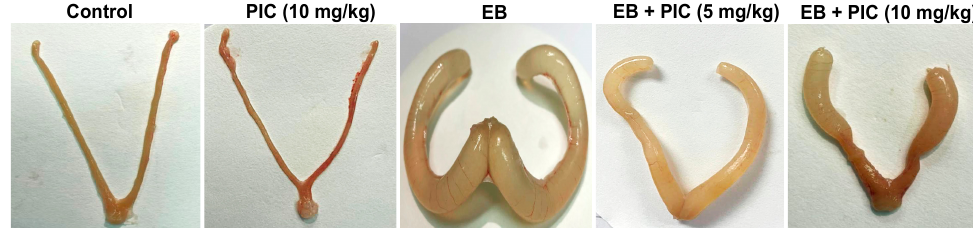
Figure 1. Effect of piceatannol SNEDDS on uterine morphology in rats treated with estradiol benzoate. Gross images of rat uteri collected after four weeks of treatment with estradiol benzoate (0.6 mg/kg) in the absence or presence of piceatannol SNEDDS (5 or 10 mg/kg). EB is estradiol benzoate, PIC is piceatannol, SNEDDS is self-nanoemulsifying drug delivery system.